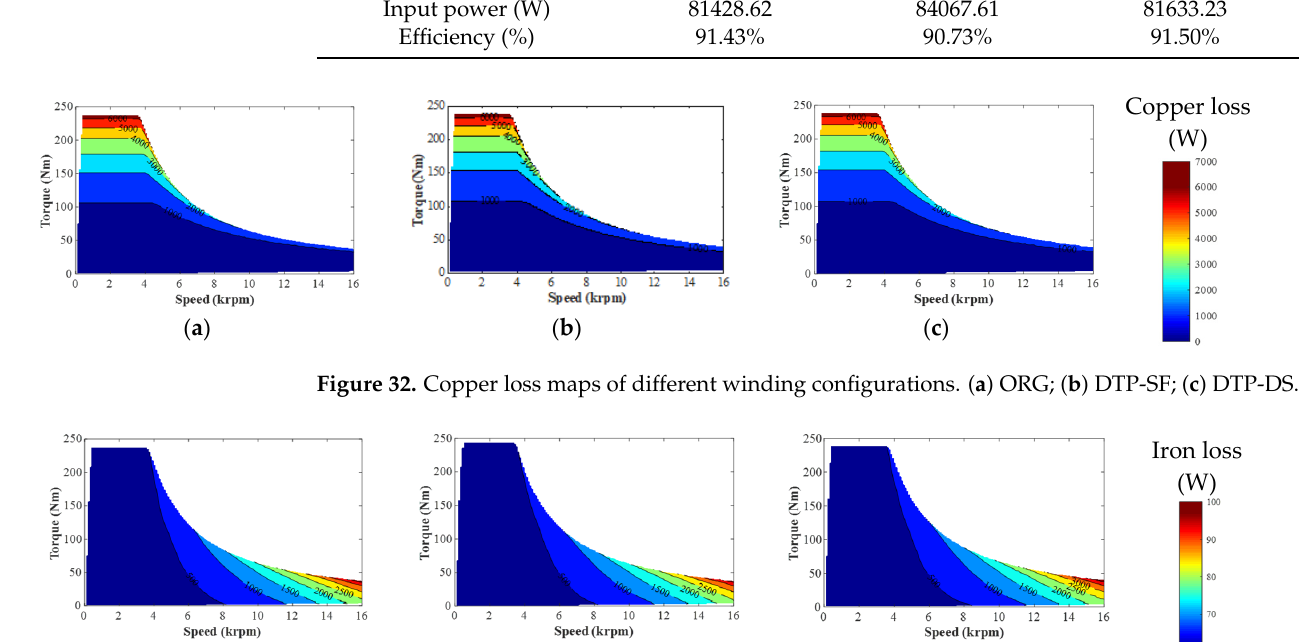
Figure 33. Iron loss maps of different winding configurations: ( a ) ORG; ( b ) DTP-SF; ( c ) DTP-DS.